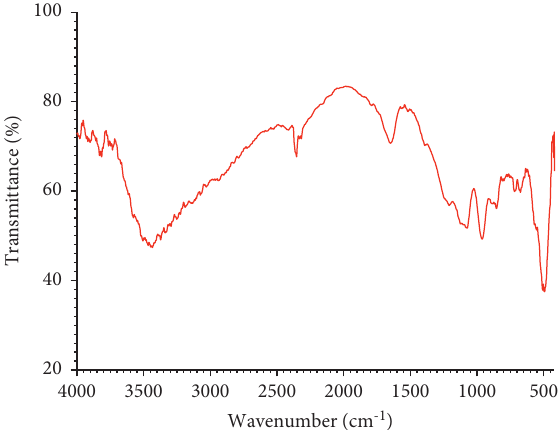
Figure 4: The FTIR spectrum of the synthesized